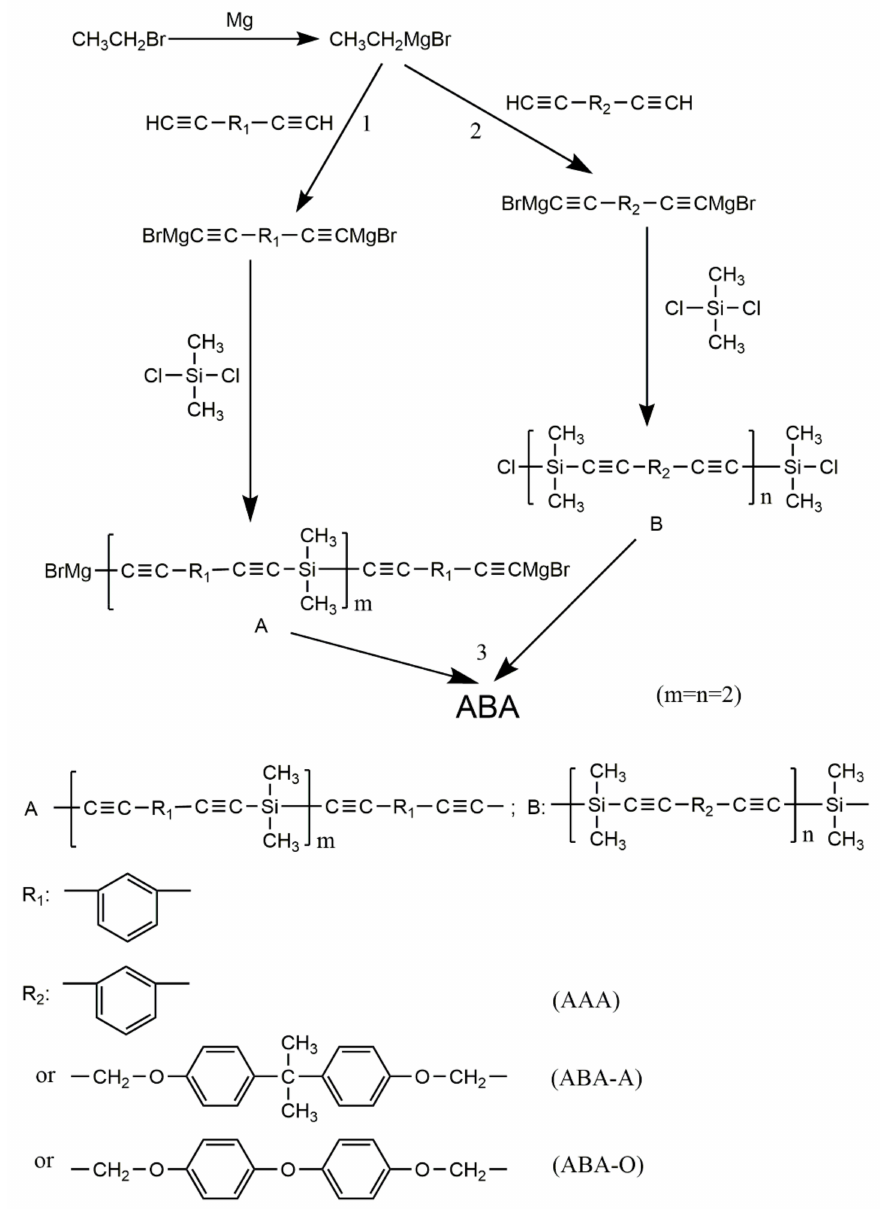
Scheme 1. Synthesis route of three